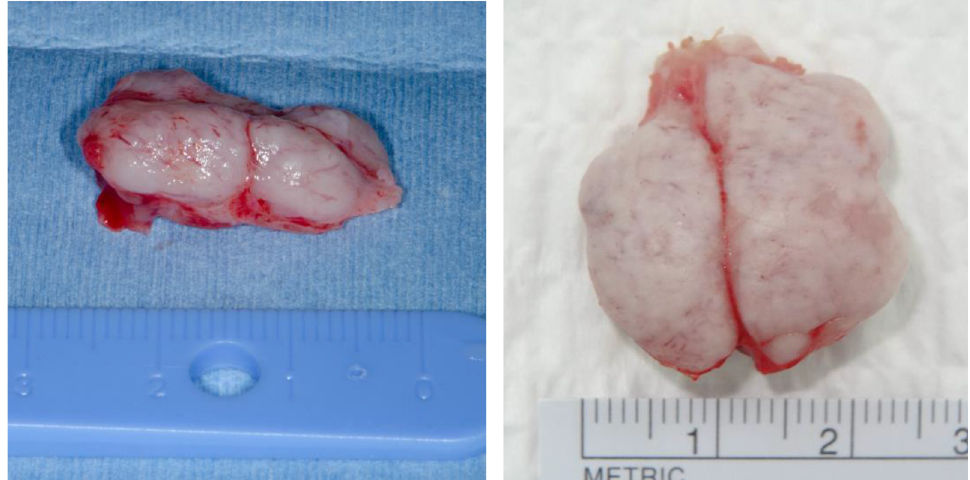
Fig. 4. Palatal tori cleaved into one operative specimen. (a) Patient T. (b) Patient V.